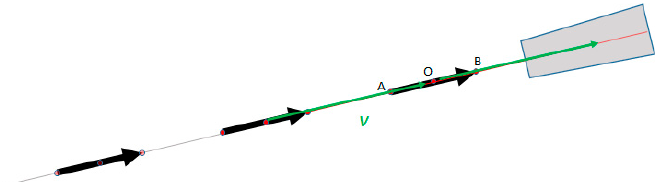
Figure 13. A tracklet in state 2: the tracklet now has speed and orientation, and new detections can only match in one direction.